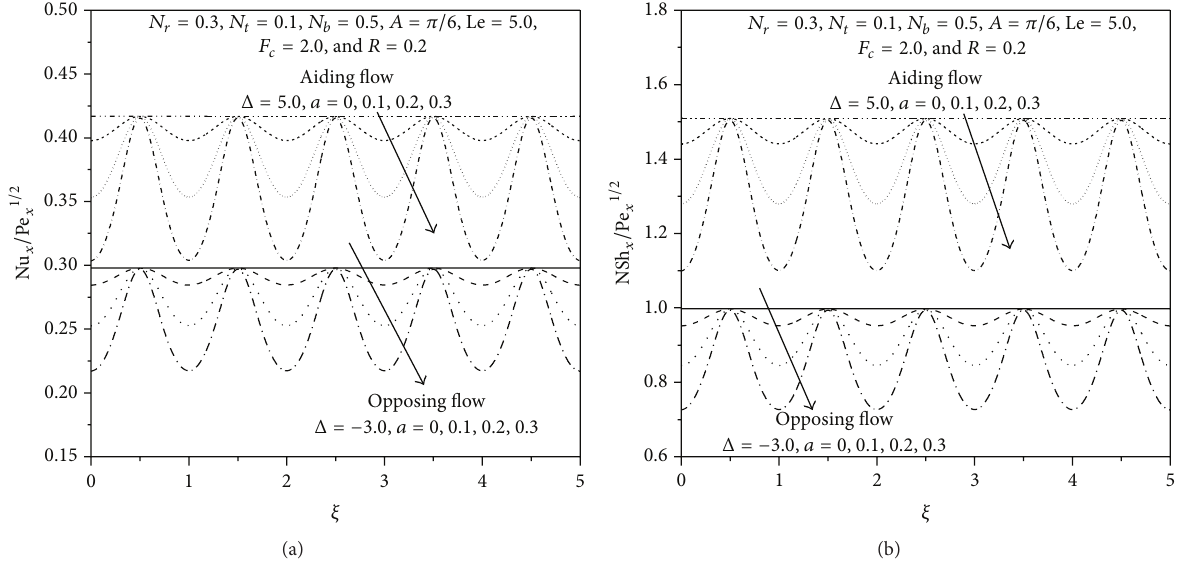
Figure 6: Effect of the wave amplitude ( 𝑎 ) on the heat and nanoparticle mass transfer rates.